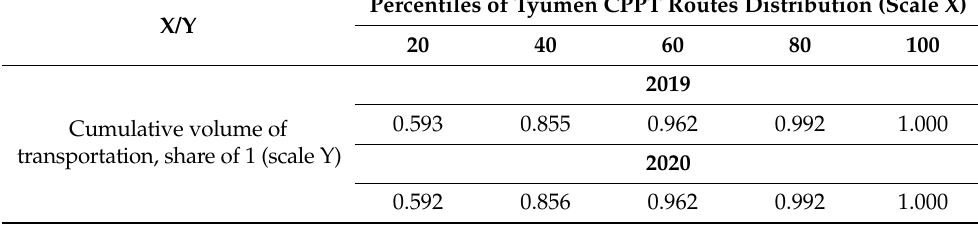
Table 8. Characteristics of cumulative curve (Lorenz curve) of distribution of annual transportation volume Q year at Tyumen CPPT routes.